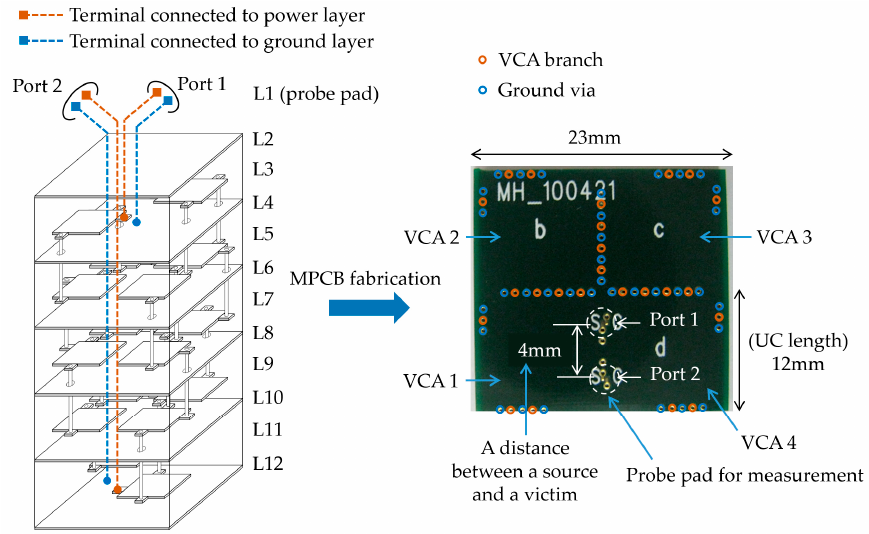
Figure 8. A test vehicle of the CMS-EBG structure fabricated by the multilayer printed circuit board (MPCB) manufacturing process.